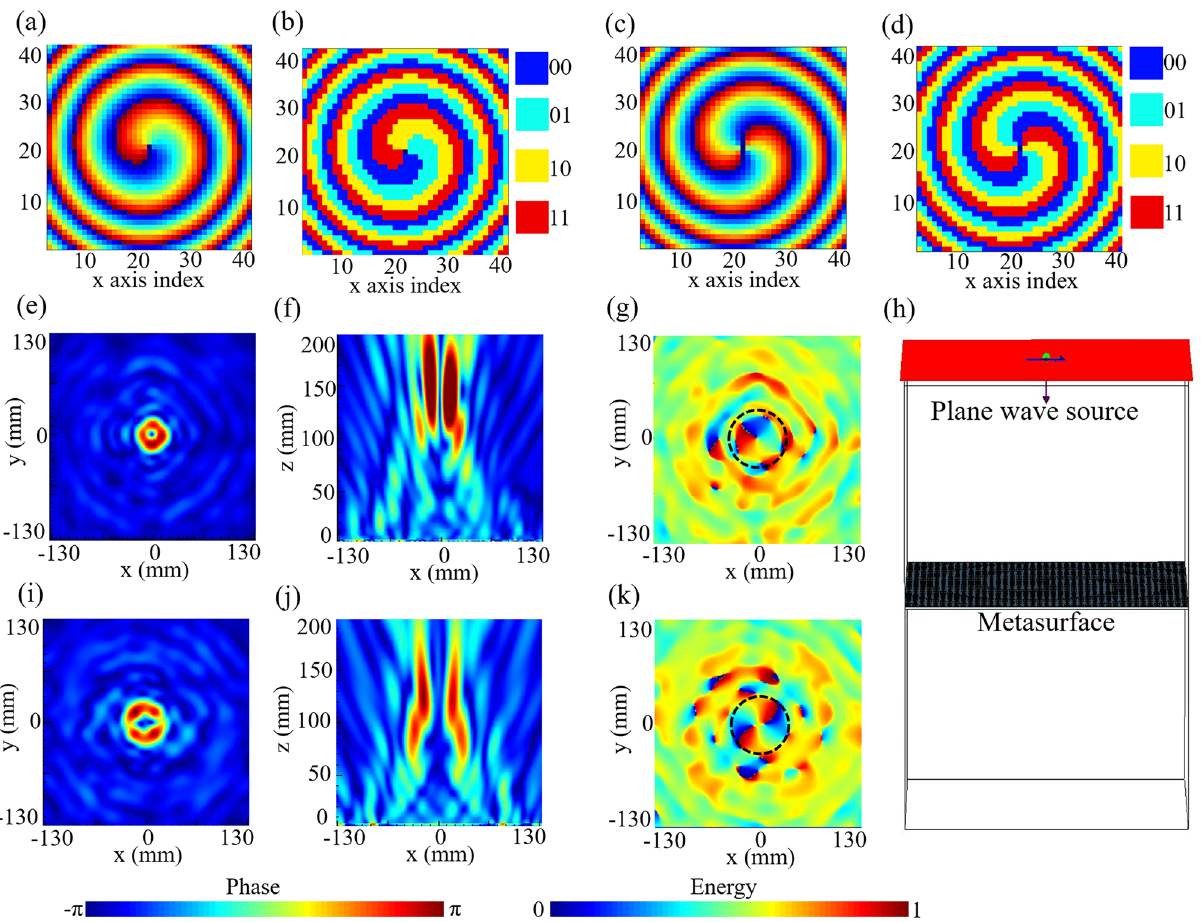
Figure 3. ( a ) Calculated phase distribution and ( b ) discretized code distribution for x -polarized incidence. ( c ) Calculated phase distribution and ( d ) discretized code distribution for y -polarized incidence. ( e ) Simulated energy distribution at z = 150 mm in xoy plane and ( f ) the corresponding phase distribution under x -polarized incidence. ( g ) Simulated energy distribution in the xoz plane under x -polarized incidence. ( h ) The simulation model in CST Microwave Studio. ( i ) Simulated energy distribution at z = 150 mm in xoy plane, and ( j ) the corresponding phase distribution under y -polarized incidence. ( k ) Simulated energy distribution in the xoz plane under y -polarized